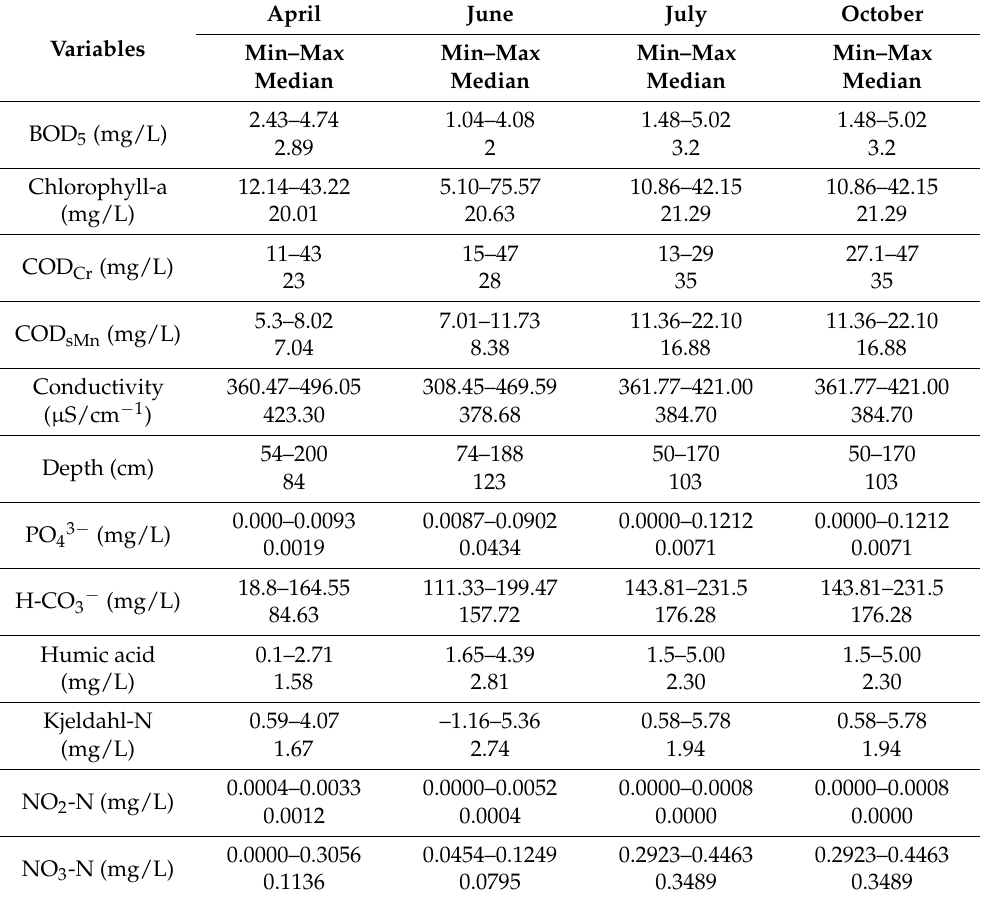
Table 1. Minimum, maximum, and median values of the physical and chemical variables for the investigated